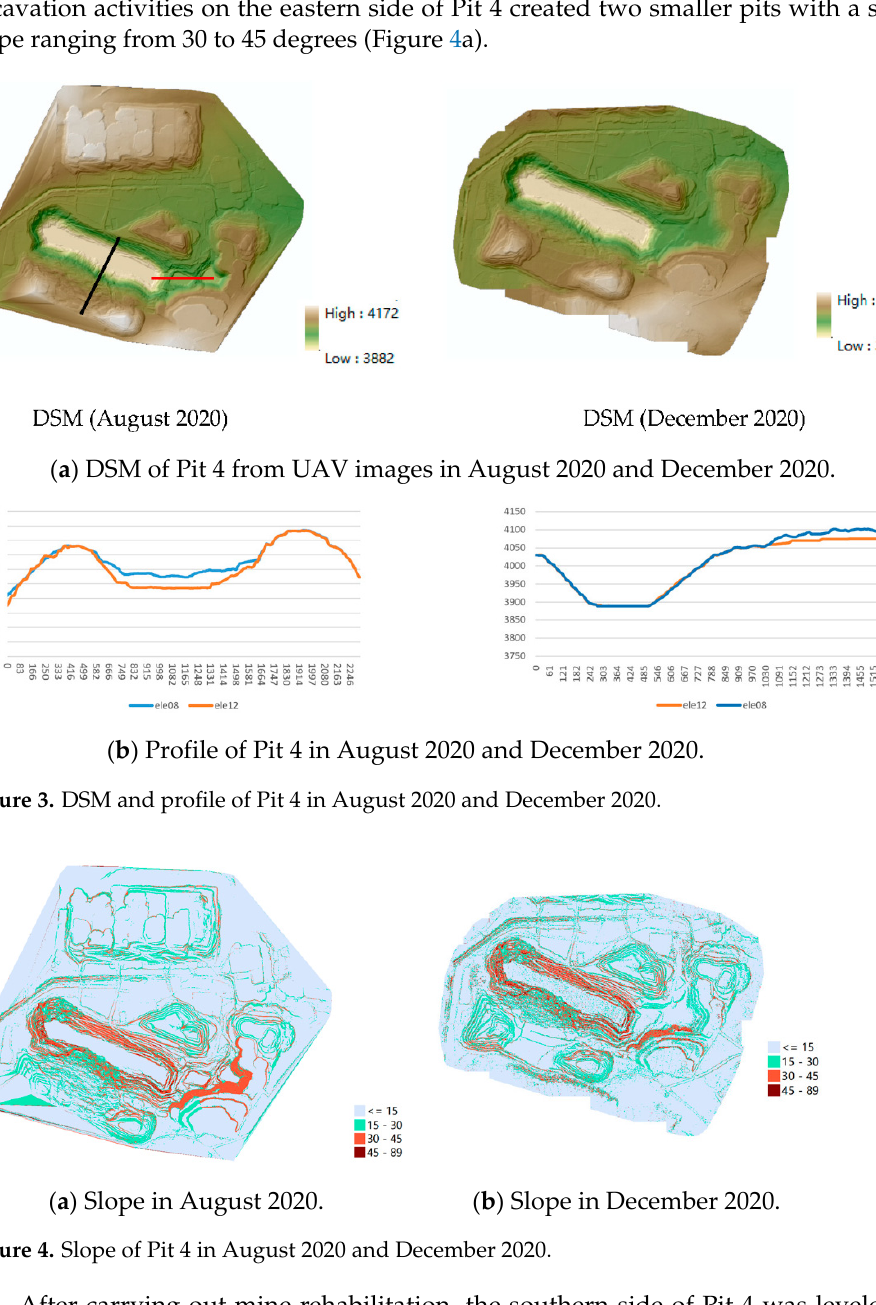
Figure 4. Slope of Pit 4 in August 2020 and December 2020.